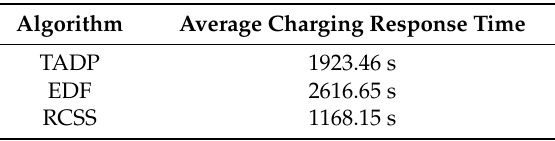
Table 5. The value of average charging response time.